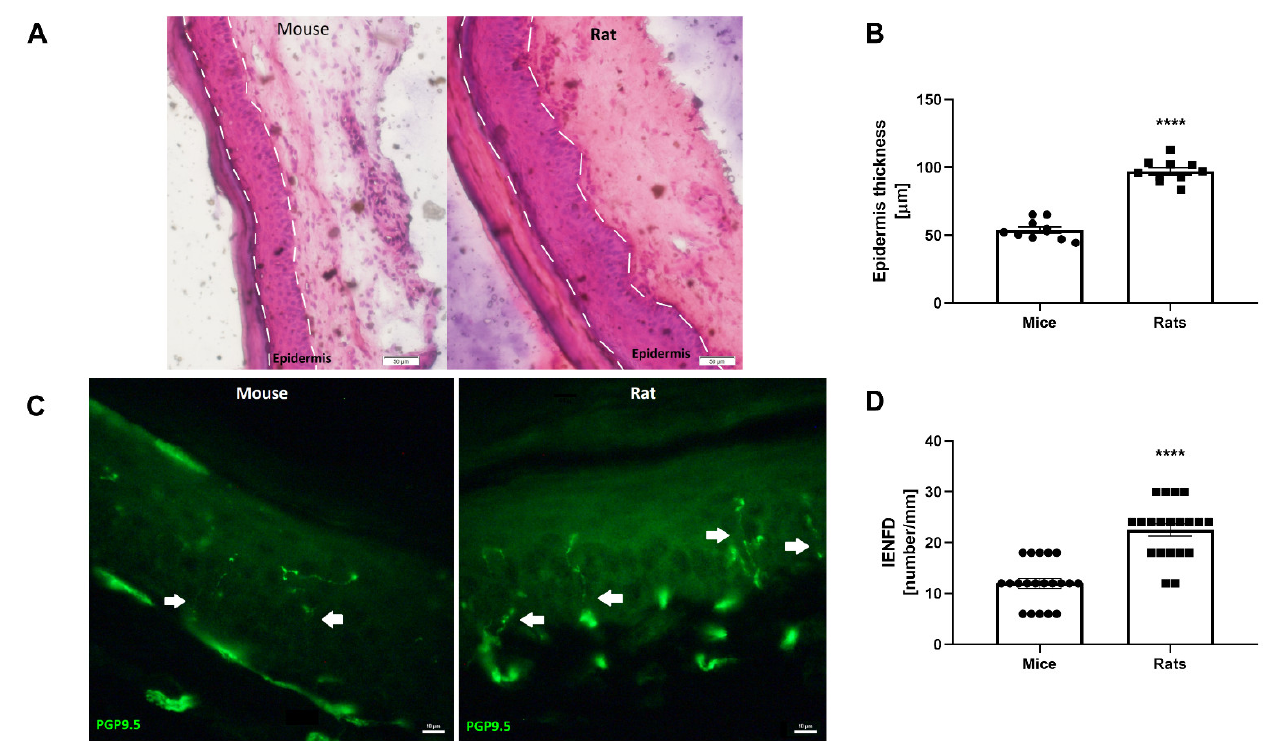
Figure 3. Structural differences between mouse and rat skin: ( A ) representative H&E staining of mouse and rat skin. Scale bar—50µm. White dashed lines represent the borders of the epidermis. Epidermis thickness was defined as the distance between the borders. ( B ) The epidermis layer was significantly thicker in rat skin compared with in mice skin, n = 10. ( C ) Representative PGP9.5 staining of mouse and rat skin. Scale bar—10µm. White arrowheads mark small-fibers. ( D ) The fiber density was significantly higher in rat skin compared with in mouse skin, n = 20. Results are presented as mean ± SEM, **** p < 0.0001.